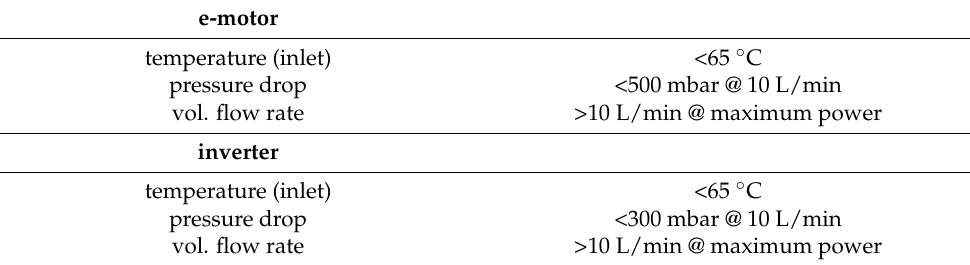
Table 4. Preliminary requirements for the cooling circuit.